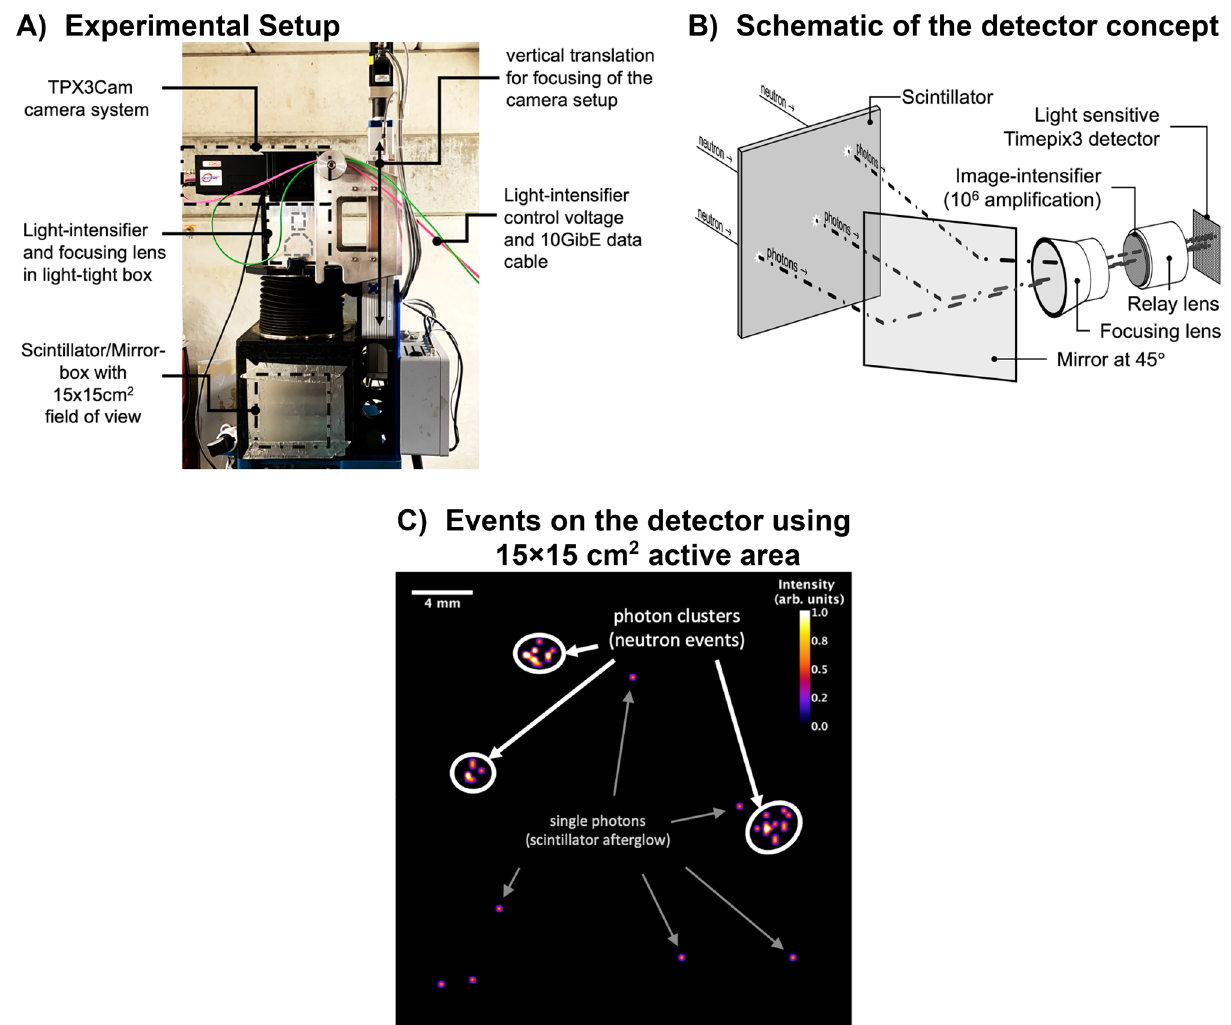
Figure 1. Photograph of the experimental setup at the BOA beam-line in ( A ). Schematic of the detector concept (not to scale) in ( B ). Single photon-events measured with Timepix3 detector in C highlighting scintillator afterglow and neutron